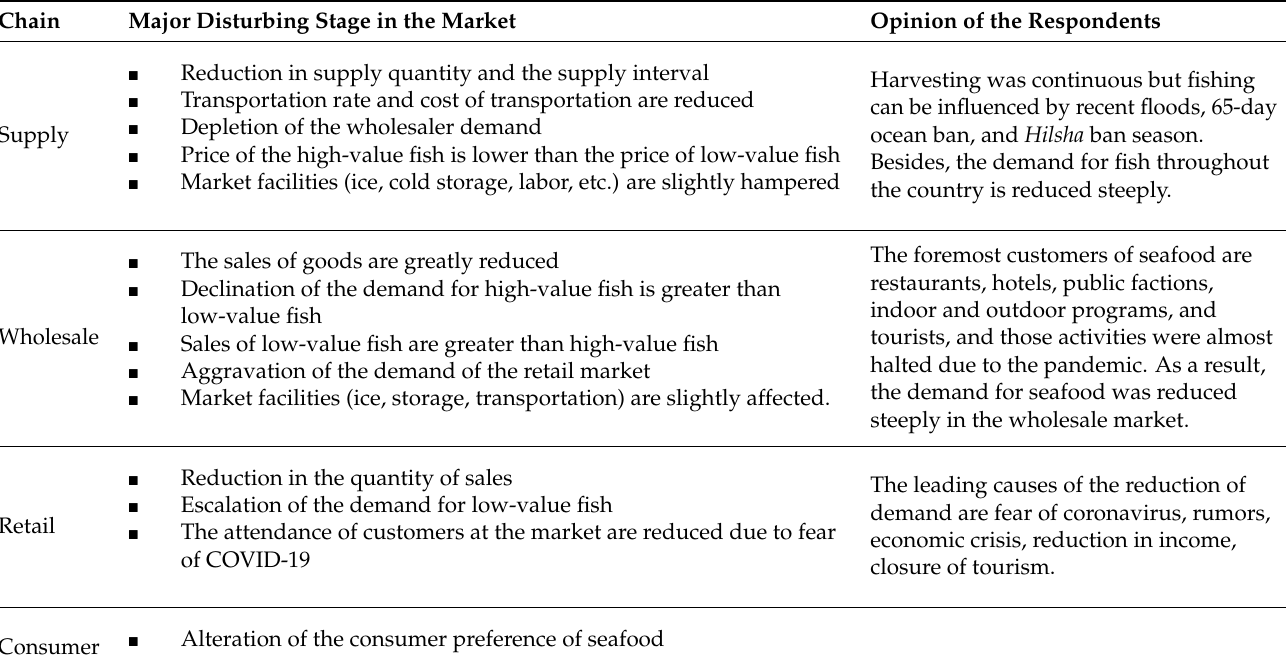
Table 4. Summary of the changes in market system due to COVID-19 on different